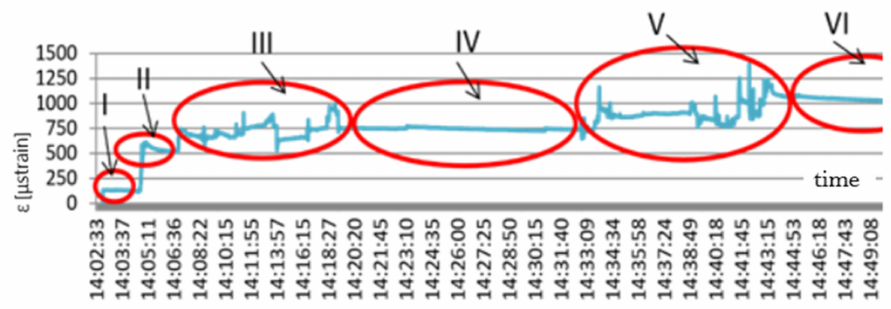
Figure 7. Scheme geogrid strains—stage zero of the monitoring: x (s); y ( µ strain). Distinct jumps in strains can be observed in Figure 8 when the compactor was directly over the sensor. After the compactor moved beyond the sensor, the strain value decreased at once. The graph also indicates that the geogrid mean strain rose cyclically. Characteristic steps (red line) appeared due to subsequent stages of the stand compaction, from 12 to 21 µ strain. Compaction of the aggregate over the part located on the natural soil resulted in different values of the geogrid strains. Distinct jumps in strains can be seen in Figure 9 when the compactor was directly over the